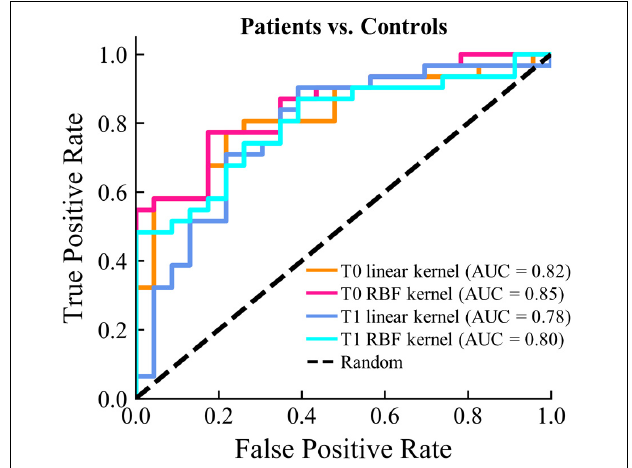
FIGURE 6 | Classifications results between patients and controls. The ROC curve and the corresponding AUC for each classification model are